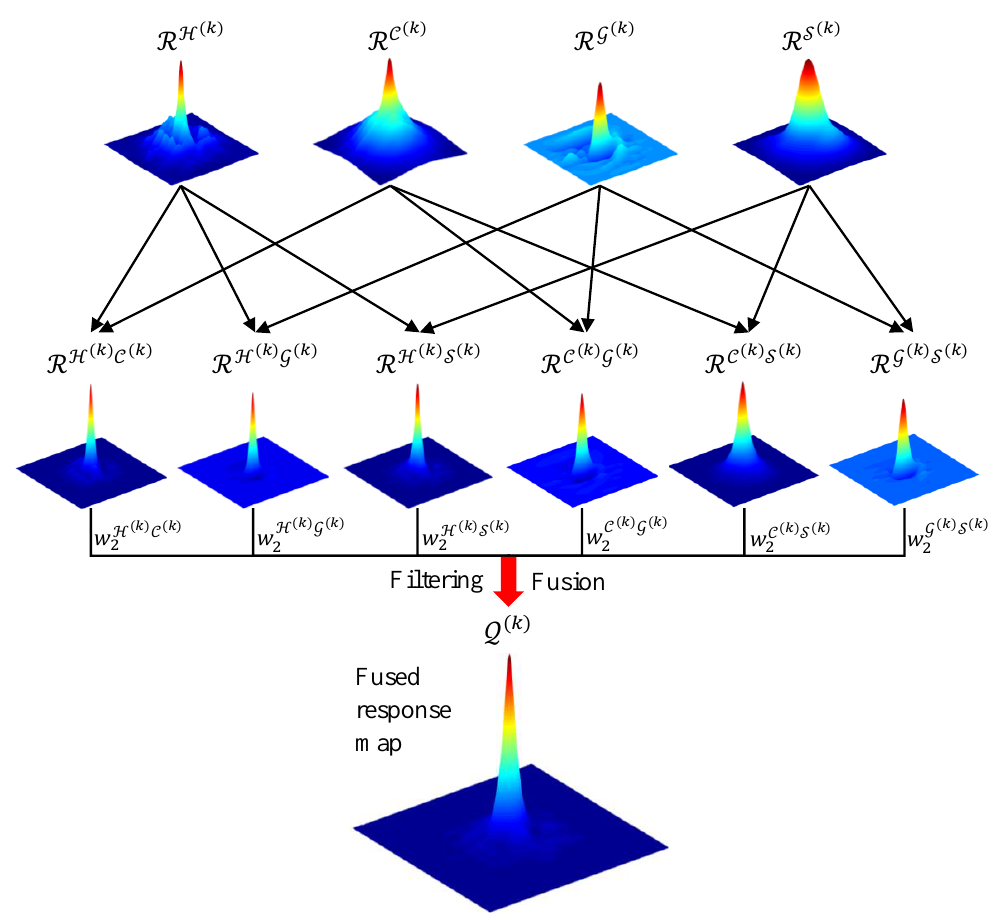
Figure 8. Fusion process of different response